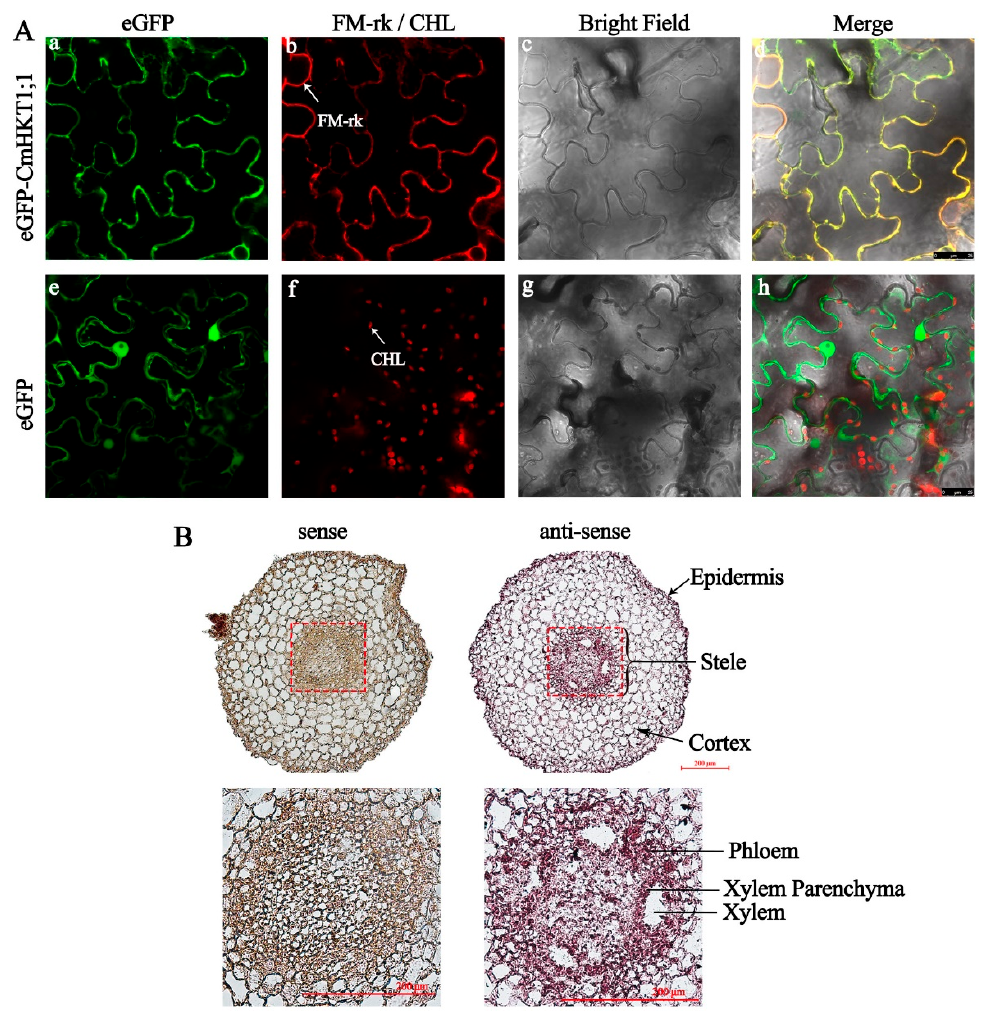
Figure 4. Membrane and cell-type localization of CmHKT1;1. ( A ) Subcellular localization of eGFP-CmHKT1;1 in the pavement cells of N. benthamiana leaves. a , Green fluorescence from eGFP-CmHKT1;1. b , Red fluorescence from PM-rk-labeled membrane in eGFP-CmHKT1;1 expressing cells. c , Bright field image of the cell shown in a and b. d , Overlay image of a, b, and c. e , Green fluorescence from the free eGFP. f , Chlorophyll autofluorescence (CHL)-derived red fluorescence in eGFP-expressing cells. g , Bright field image of the cell shown in e and f. h , Overlay image of e, f, and g. ( B ) Localization of CmHKT1;1 mRNA in pumpkin root by in situ hybridization. Three true leaves aged pumpkin seedlings were subjected to 75 mM NaCl for 24 h before tissue collection. Cells in which transcript is present stain red-brown. Magnified views are shown below. Left panel, Sense probe. Right panel, antisense probe. The indication marks on the root cross section show the different tissues. Bars = 200 µm.